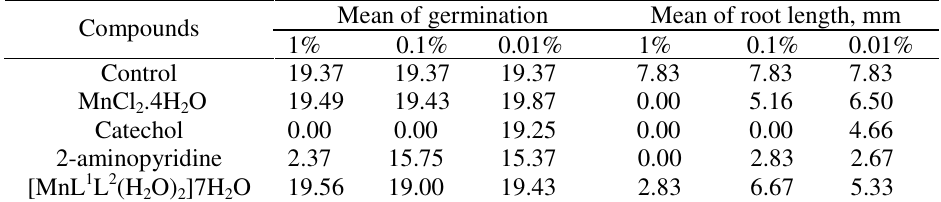
Table 1. Effect of metal salt, ligands and their complexes on seed germination and root length at 1,2,3 and 4